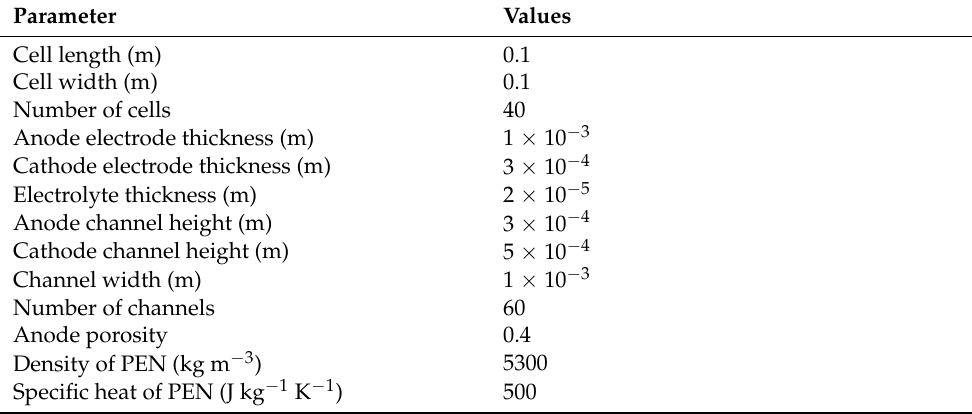
Table 2. A SOFC stack specifications.